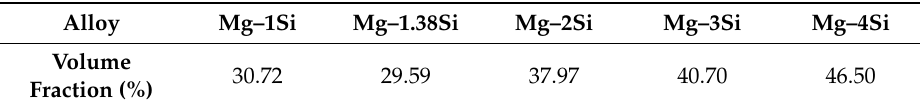
Table 3. The second phase volume fraction of Mg–Si binary